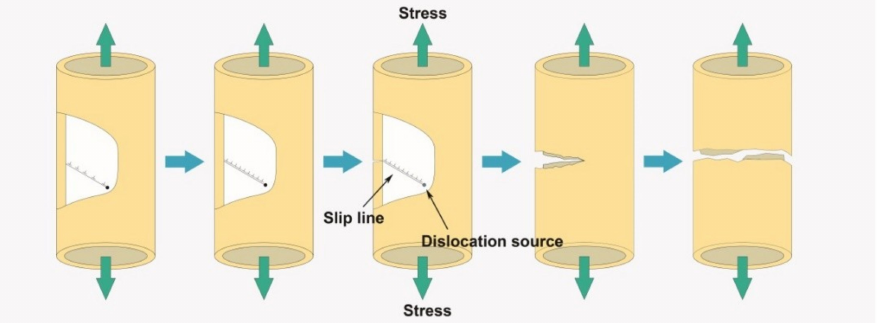
Figure 13. Schematic illustration of coated sample under tensile